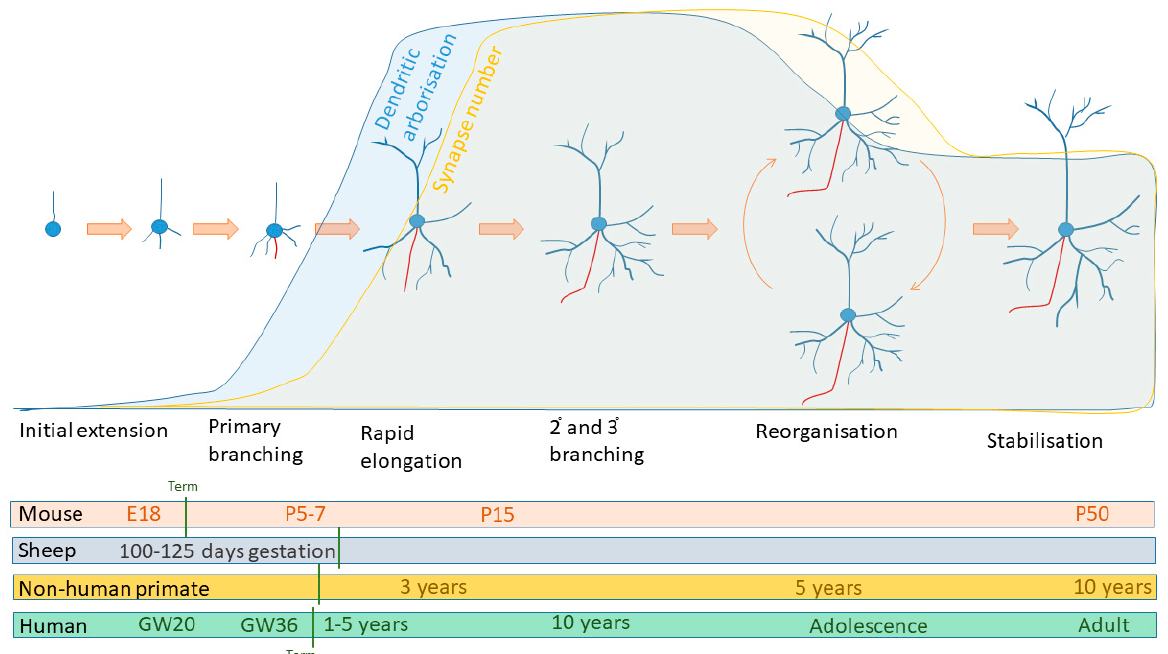
Figure 2. Schematic diagram summarising the comparative timeframe in which key events in dendritic arborisation occur. Dendritic branching commences with primary branch formation, immediately following neuronal migration to its final position. Processes of branching then occur to form secondary and tertiary branches, as well as branch elongation. During this period, is the initial formation of dendritic spines and, subsequently, of synapses. Reorganisation and stabilisation of the dendritic branches, spines, and synapses occur relatively late in the developmental processes. The comparative time frame of these events is shown for the mouse, sheep, non-human primate, and human brain. E—embryonic day, GW—gestational week, P—postnatal